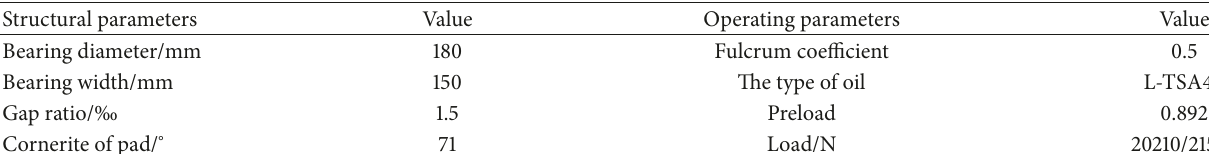
Table 1: The structural and operating parameters of the four-lobe bearing.